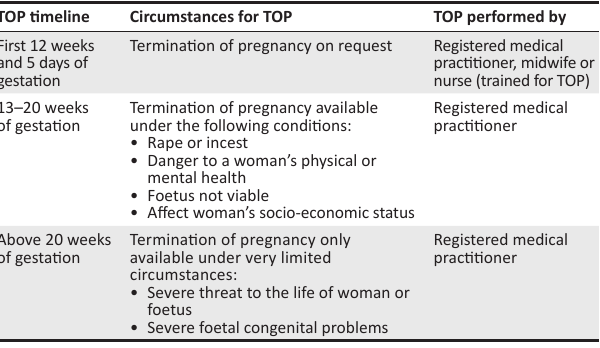
TABLE 1: Circumstances and timeline for termination of pregnancy under the Choice on Termination of Pregnancy Act. 3